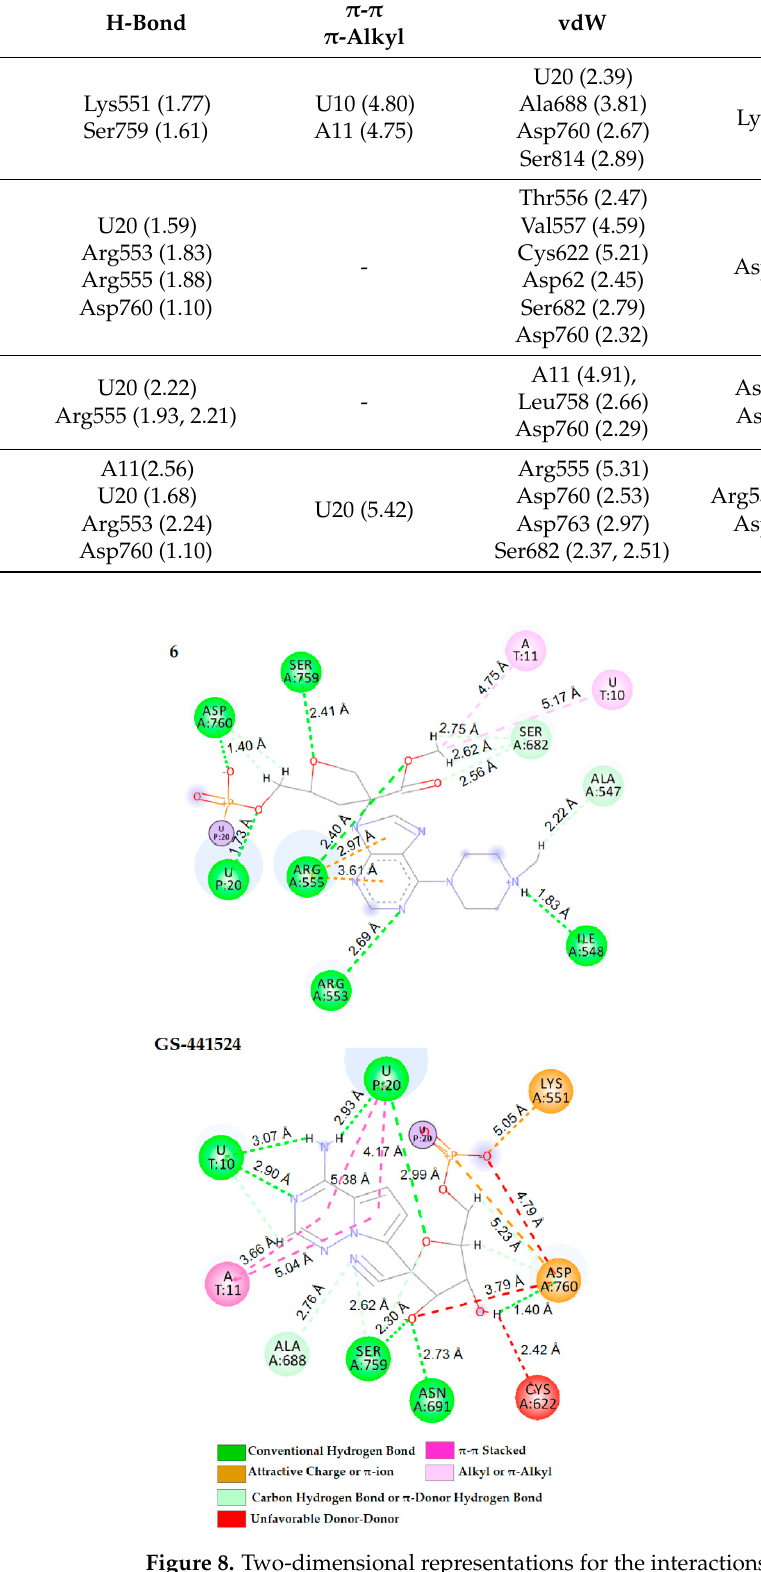
Figure 8. Two-dimensional representations for the interactions of both compound 6 and GS-441524 linked as monophosphate to RNA in the receptor pocket of free RdRp (7BV2) with indication of interaction distance, as deduced by docking calculations.